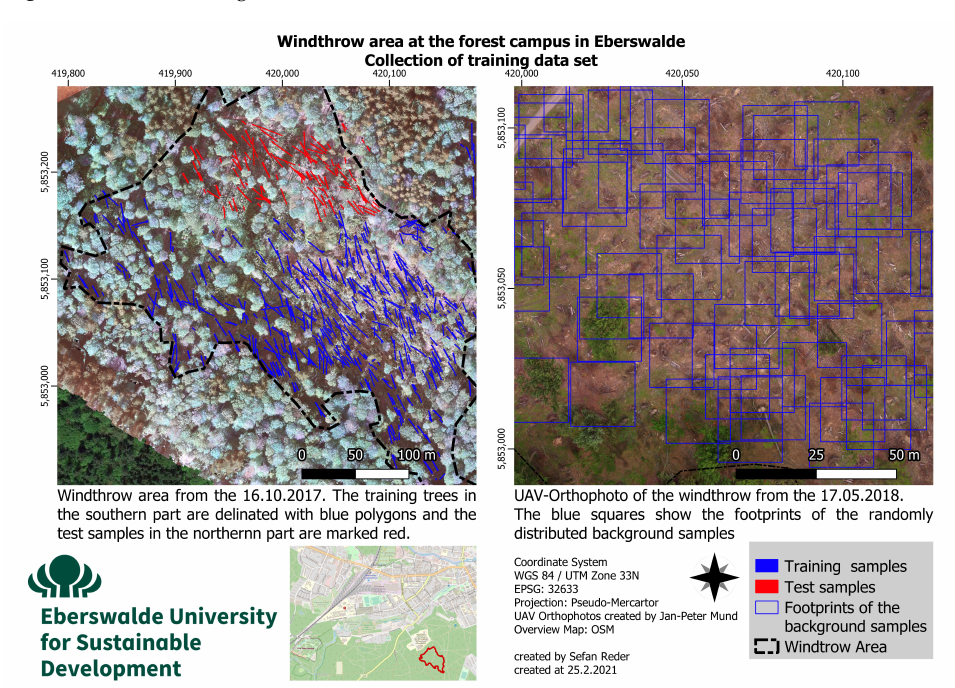
Figure 2. Windthrow area in Eberswalde. The blue stems ( left ) in the southern part of the windthrow area were used to create the training datasets. The red stems were used as test dataset for the evaluation of the model performance. The blue squares ( right ) represent the footprints of the background images used for the data